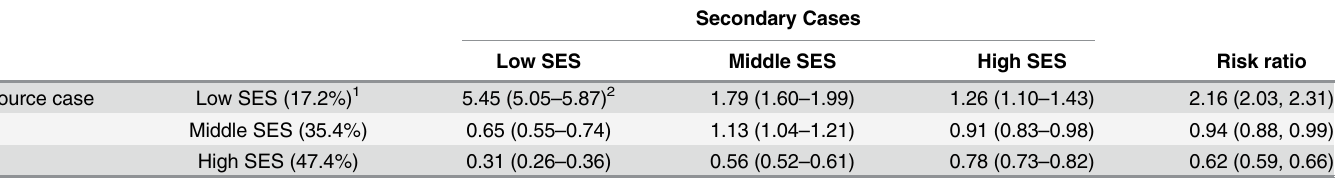
Table 3. Risk ratio of transmission to secondary cases in low, middle, or high SES communities, given SES of the source